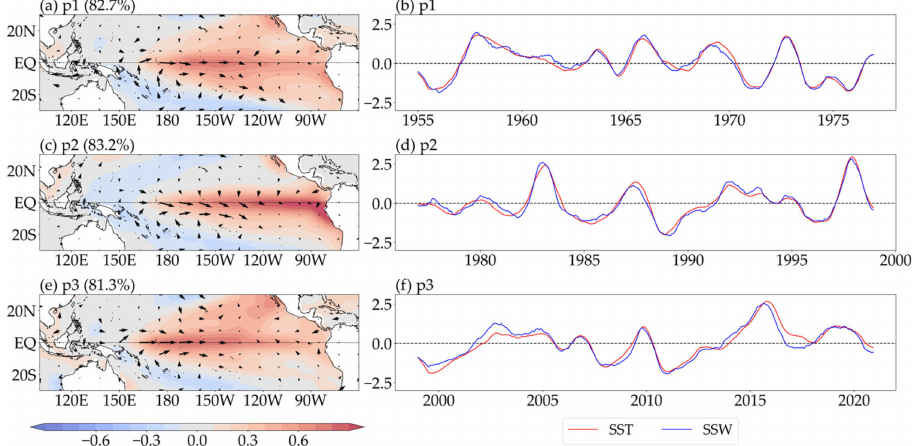
Figure 8. The SVD first spatial mode of SST anomalies (blue-red scale) and sea surface wind (SSW) anomalies (arrows) during three periods ( a , c , e ) and their corresponding time coefficient series ( b , d , f ). The p1, p2, and p3 are the same as in Figure 1. The percentages in parentheses ( a , c , e ) indicate the covariance contribution rates of the first